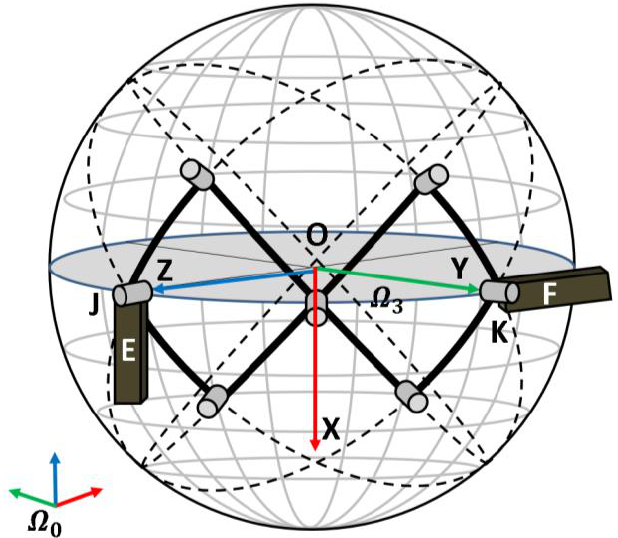
Figure 7. Coordinate system of the base frame and the upper arm frame in the initial state.